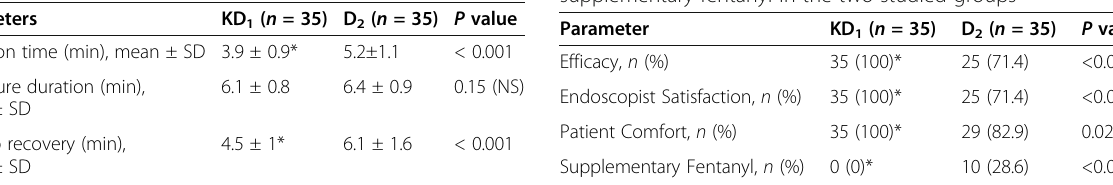
Table 3 Efficacy, endoscopist satisfaction, patient comfort, and supplementary fentanyl in the two studied